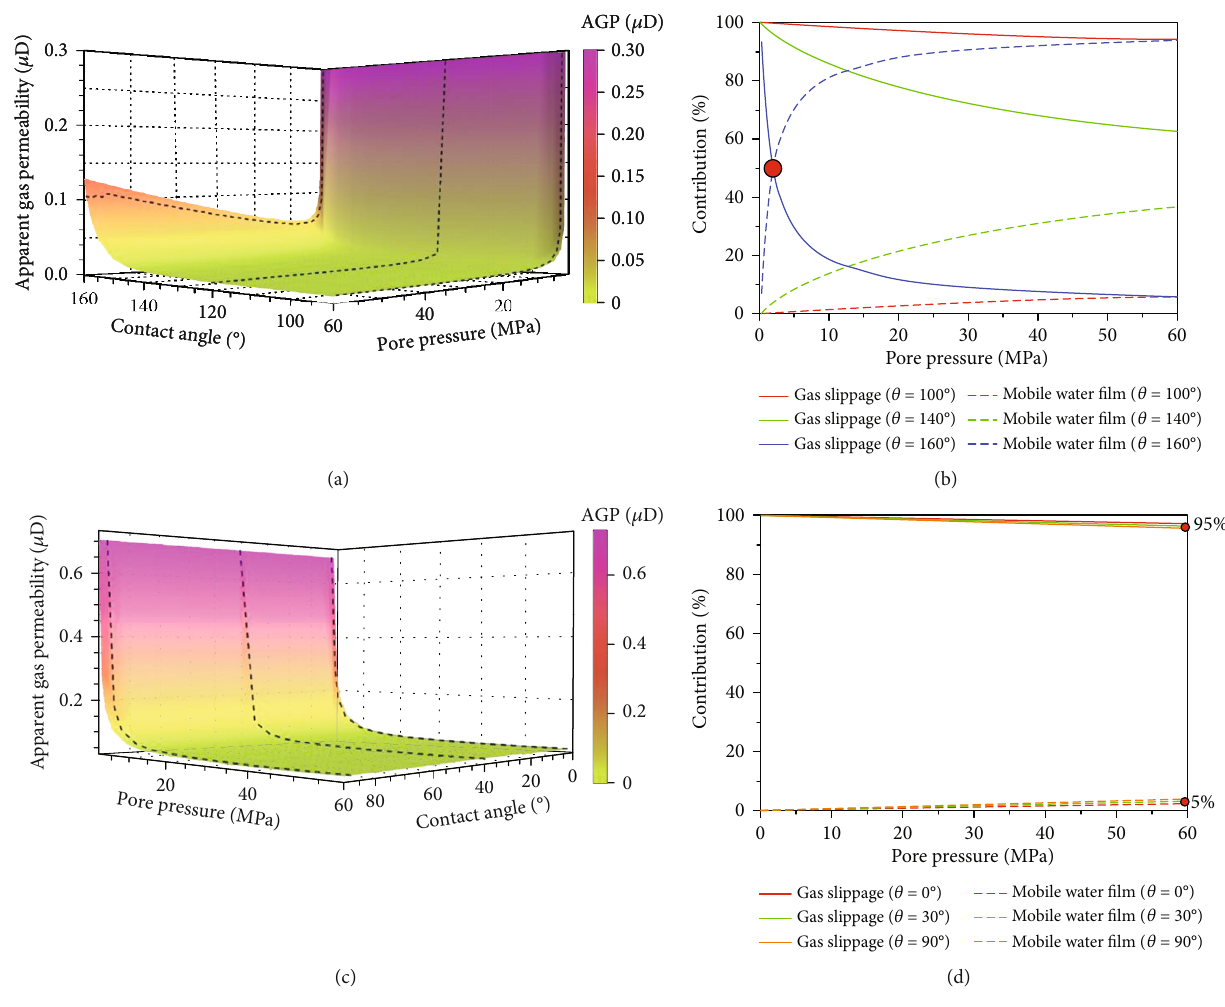
Figure 7: The impacts of pore pressure and contact angle on the gas fl ow. (a) The AGP of OM varies with pore pressure at di ff erent contact angles. (b) Contributions of gas slippage and water fi lm mobility to gas fl ow in OM. (c) The AGP of iOM varies with pore pressure at di ff erent contact angles. (d) Contributions of gas slippage and water fi lm mobility to gas fl ow in